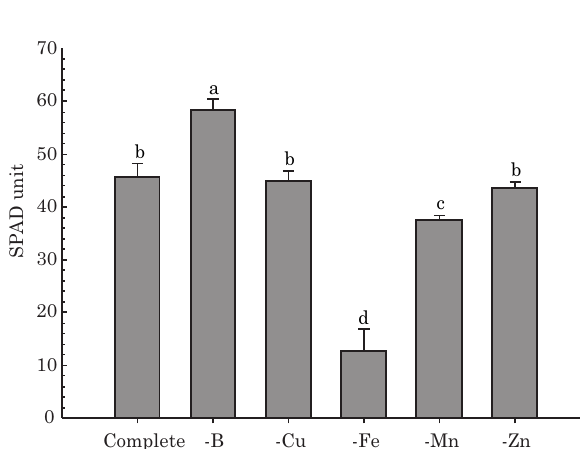
Figure 2. Chlorophyll content in SPAD units, measured in the middle lobe of the third and fourth recently expanded leaves of physic nut grown in complete nutrient solution and in absence of B, Cu, Fe, Mn, and Zn, 105 days after the start of the treatments. Means followed by the same letter are not significantly different by Tukey’s test at